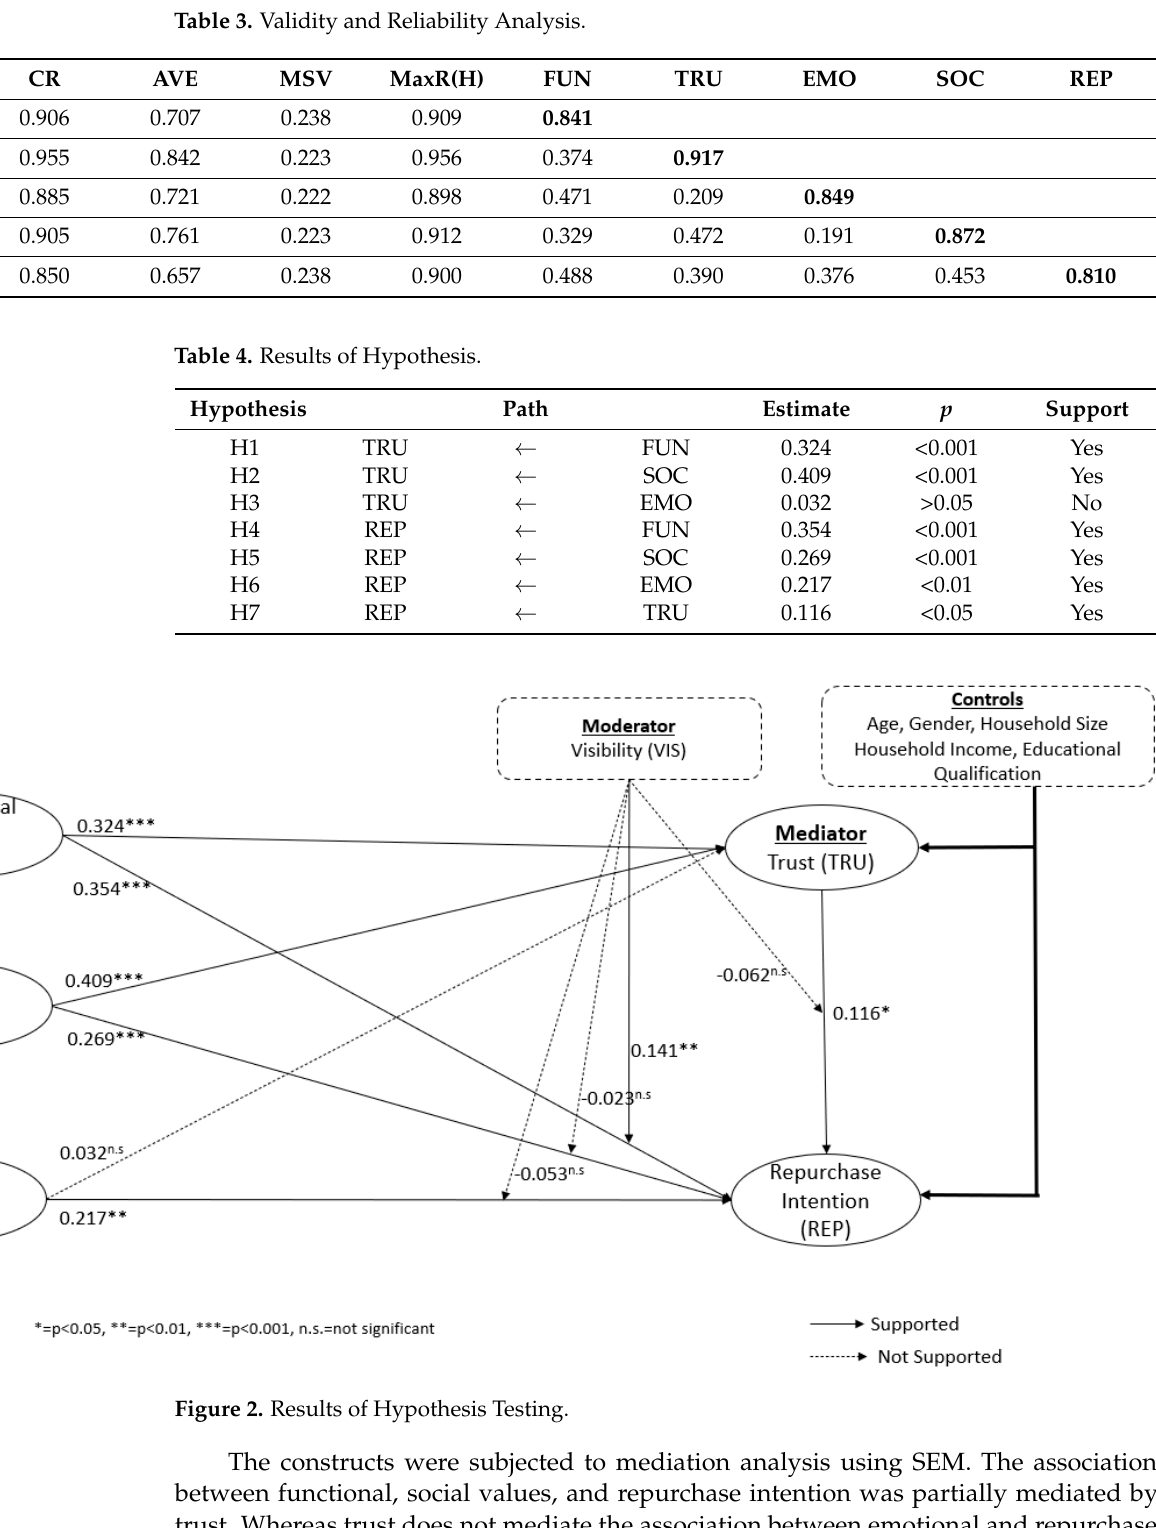
Table 3. Validity and Reliability Analysis.